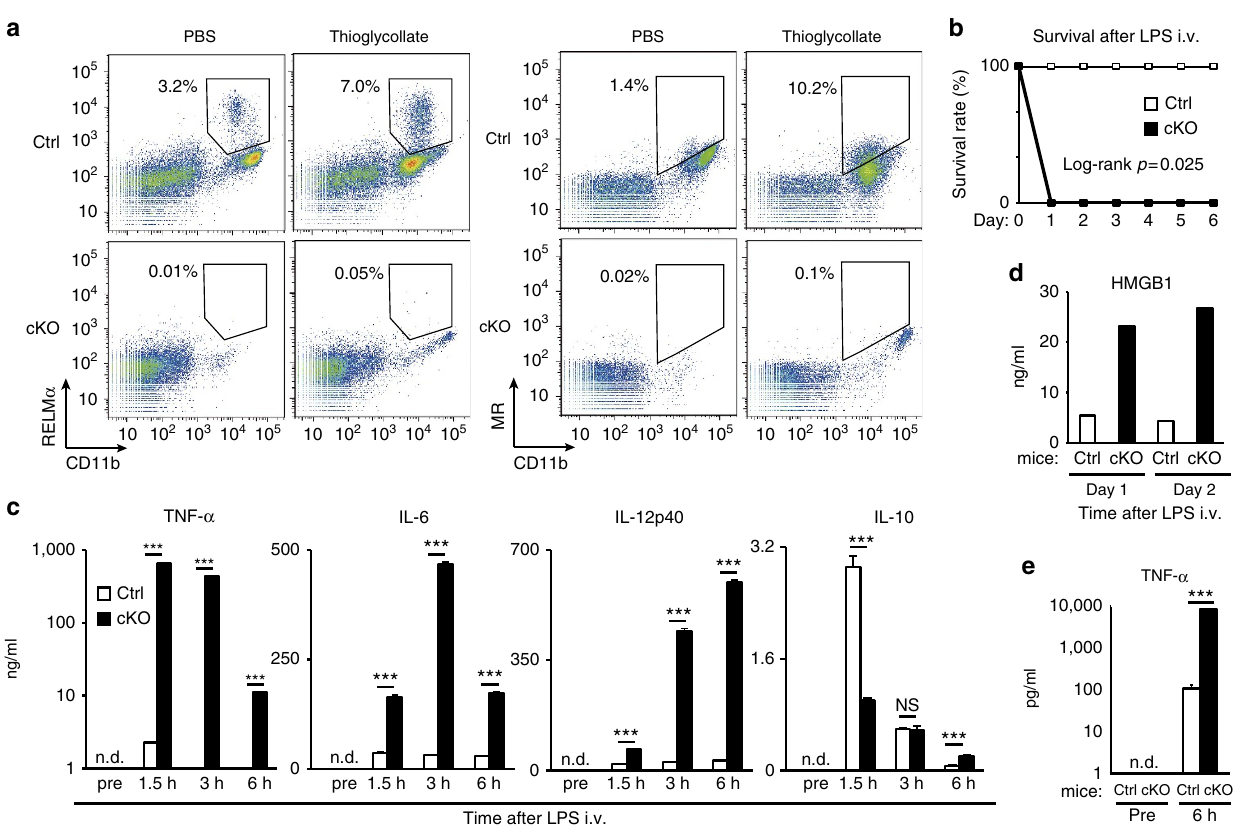
Figure 2 | Defective polarization of M2 macrophages and enhanced innate immune response in myeloid (cid:2) specific Lamtor1 conditional knockout mice. ( a ) M2 macrophages appeared in peritoneal cavity 6 days after the intraperitoneal administration of thioglycollate medium. M2 macrophages (CD11b high RELM a þ cells or CD11b high MR þ cells; definition of the positive gates are described in Method section) were counted by flow cytometry. Percentage of M2 macrophages in whole peritoneal white blood cells is shown. ( b – e ) Enhanced innate immune response in Lamtor1 conditional knockout mice. ( b ) High mortality in Lamtor1 conditional knockout mice after injection of LPS (20 m g per mouse). Three mice were used for each genotype. ( c ) Serum levels of cytokines after intravenous administration of LPS (20 m g per mouse). Time from LPS administration to blood collection is indicated. ( d ) Serum HMGB1 levels at the indicated days after intravenous administration of LPS (5 m g per mouse). ( e ) Serum concentrations of TNF- a after intravenous administration of Zymosan A. Time from Zymosan A administration to blood collection is indicated. Concentrations of each cytokine and HMGB1 were measured by ELISA. Ctrl: littermate Lamtor1 flox/flox ; cKO: Lamtor1 flox/flox LysM-Cre mice. Samples were measured in triplicate ( c , e ). The representative results of